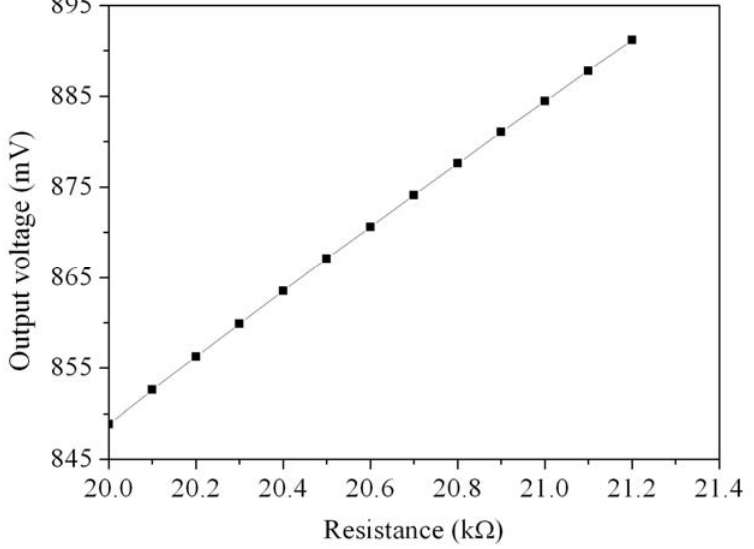
Figure 7. Simulated results of the output voltage for the CO